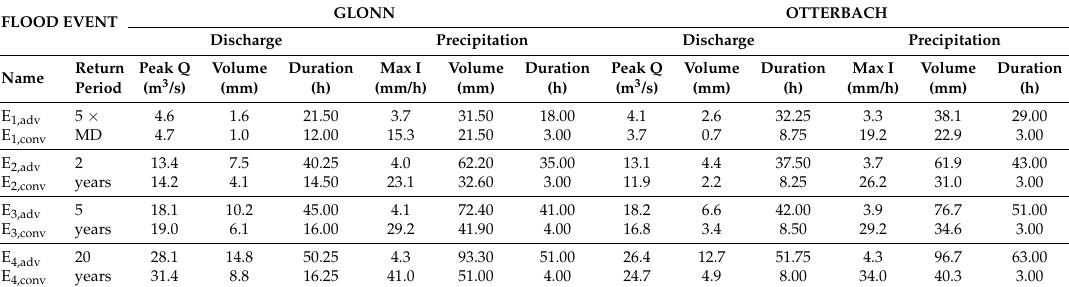
Table 2. Characteristics of the floods at gauge locations (Glonn: Odelzhausen, Otterbach: Hammermühle) and the respective precipitation events. The flood volumes and the duration refer to the period between the beginning of the flood event and reaching the peak discharge. FLOOD EVENT GLONN OTTERBACH Discharge Precipitation Discharge Precipitation